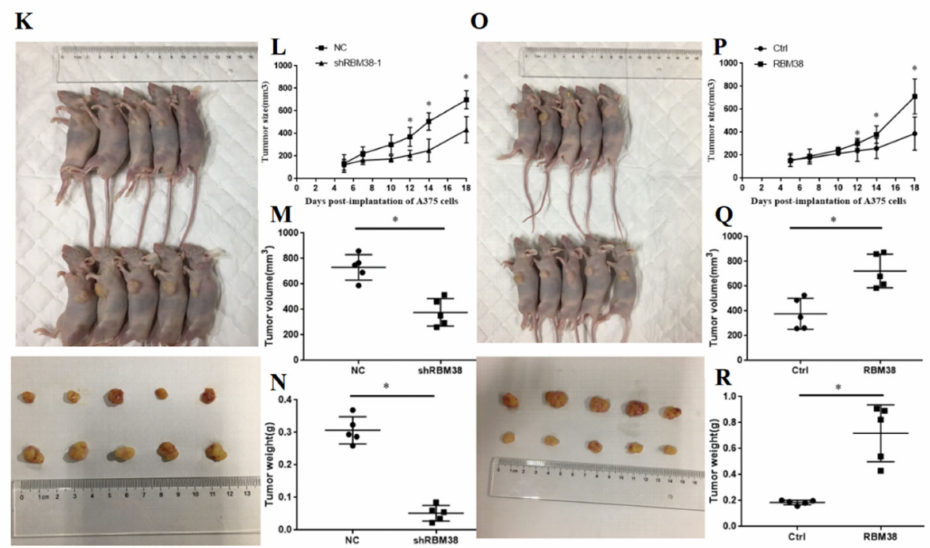
Figure 2. RBM38 promoted melanoma cell proliferation in vitro and vivo. ( A – D ) In A375 and M14 cells, the CCK-8 assay exhibited the effect of overexpression and downregulation of RBM38 on cell proliferation (data are shown as the mean ± SD of three replicates). ( E – J ) In A375 and M14 cells, colony formation assays exhibited the effect of overexpression and downregulation of RBM38 on cell proliferation. (Data are shown as the mean ± SD of three replicates). ( K – N ) Knockdown of RBM38 expression significantly inhibited melanoma cancer cell growth in nude mice and tumor volume weight was significantly reduced in the sh-RBM38 group compared to that in the NC group (there are five mouse tumors in each group). ( O – R ) Overexpression of RBM38 expression significantly increased melanoma cancer cell growth in nude mice and tumor volume weight significantly increased in the RBM38 group compared to that in the Ctrl group (there are five mouse tumors in each group) (for statistical comparison between two independent experimental groups (Student’s t -test) and among more than two experimental groups (ANOVA test), appropriated statistical tests were